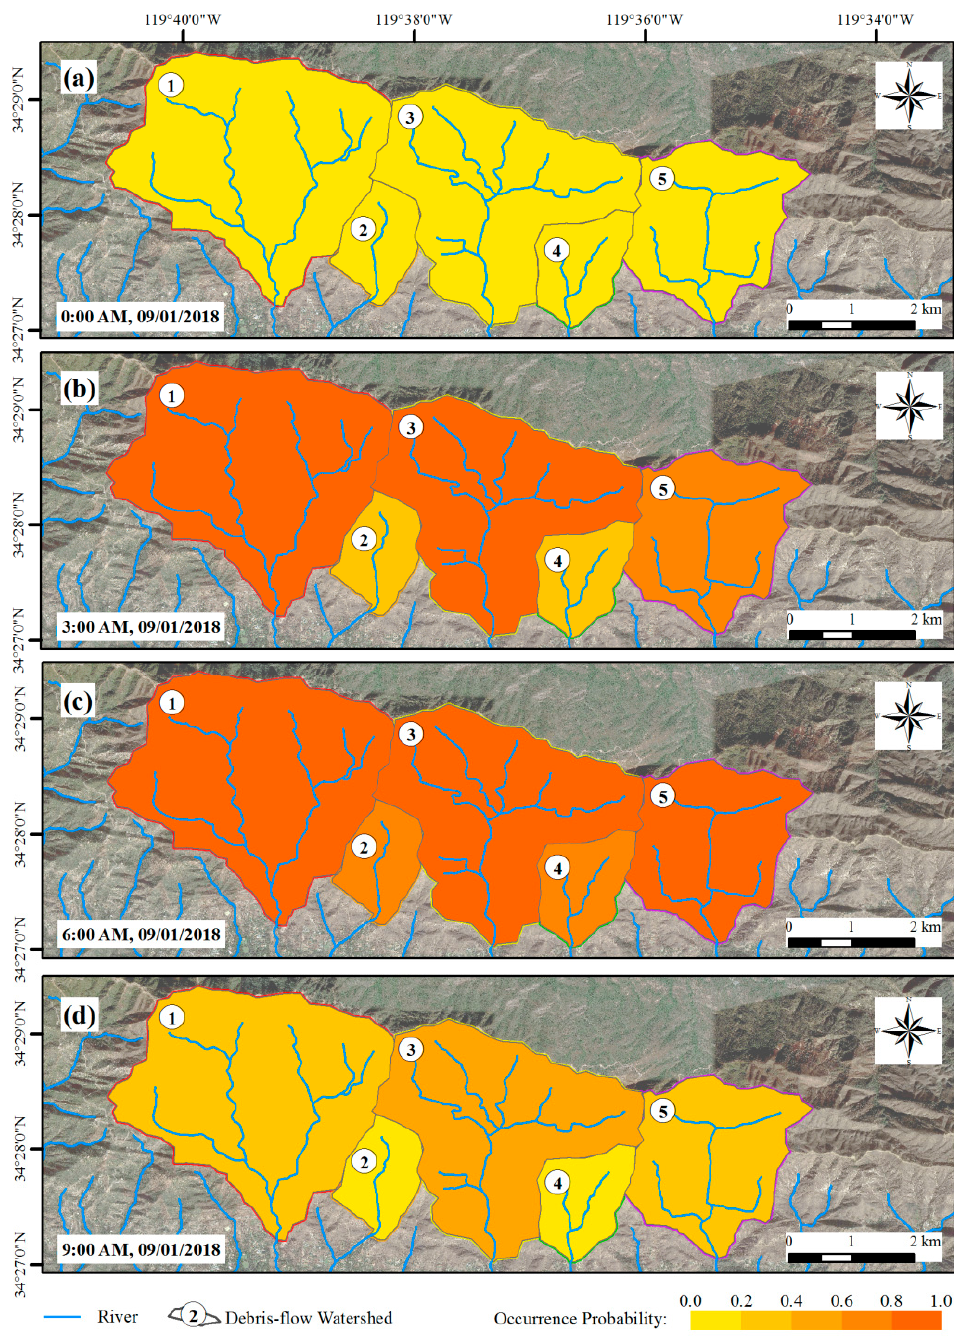
Figure 13. Spatial display of post-fire debris flow occurrence probability of each watershed around Montecito at different times on 9 January 2018: ( a ) 0:00 AM; ( b ) 3:00 AM; ( c ) 6:00 AM; ( d ) 9:00 AM